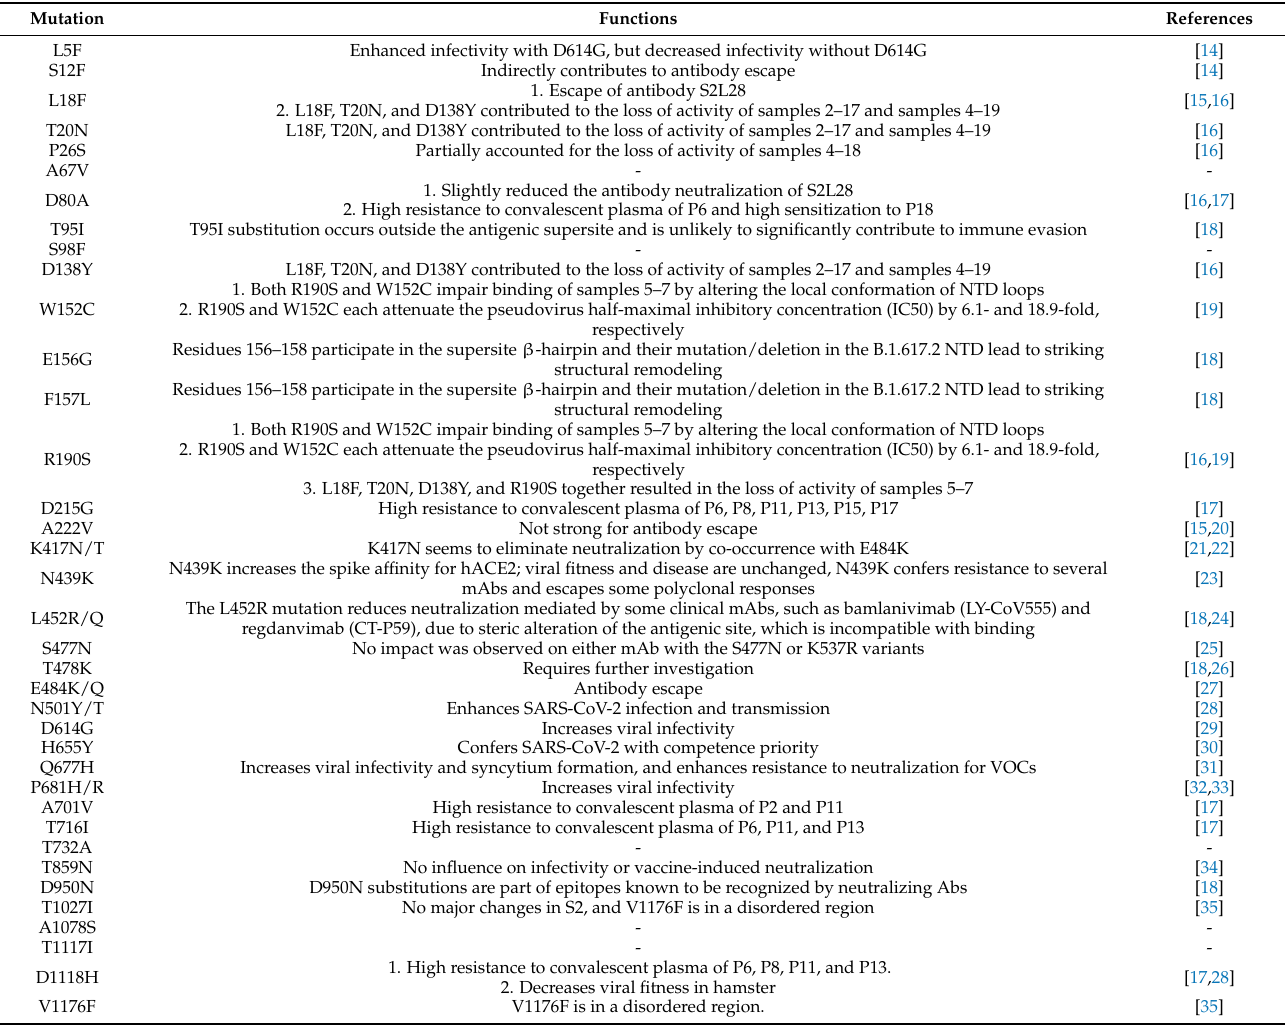
Table 1. Experimental evidence for the identified paraFix mutations of